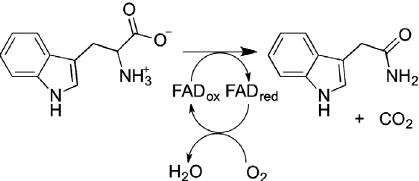
Scheme 7 Reaction catalyzed by